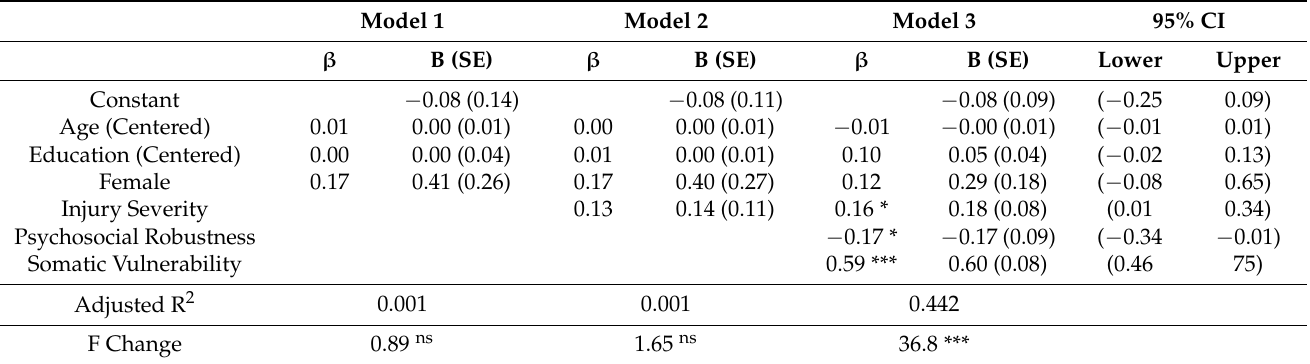
Table 3. Blockwise multiple linear regression (N = 96). Unstandardized (B) and standardized coeffi- cients ( β ) are reported. Adjusted R 2 shows the model-explained variance, and the F change-statistic is a test of the improvement from the previous model. Standard errors (SE) shown are calculated from bootstrapping. The final column shows the 95% confidence interval for the